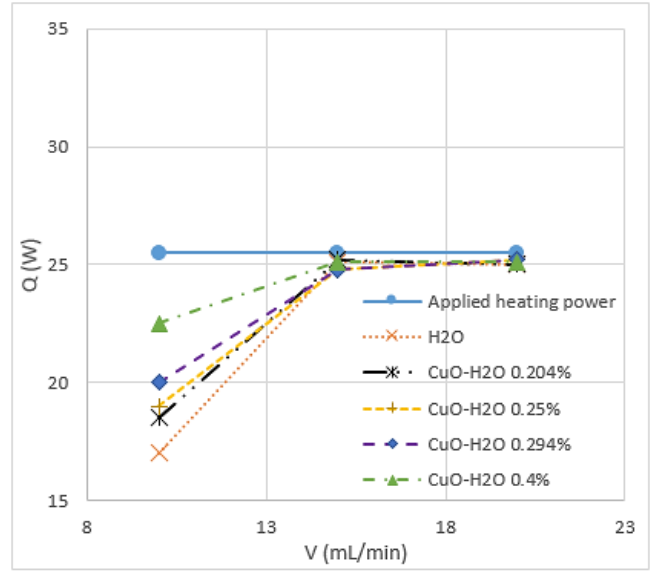
Figure 2. Heat transfer rate (Q) of CuO rectangular nanoparticles with different concentrations in water versus volume flow rate ( V ̇ ). [66]